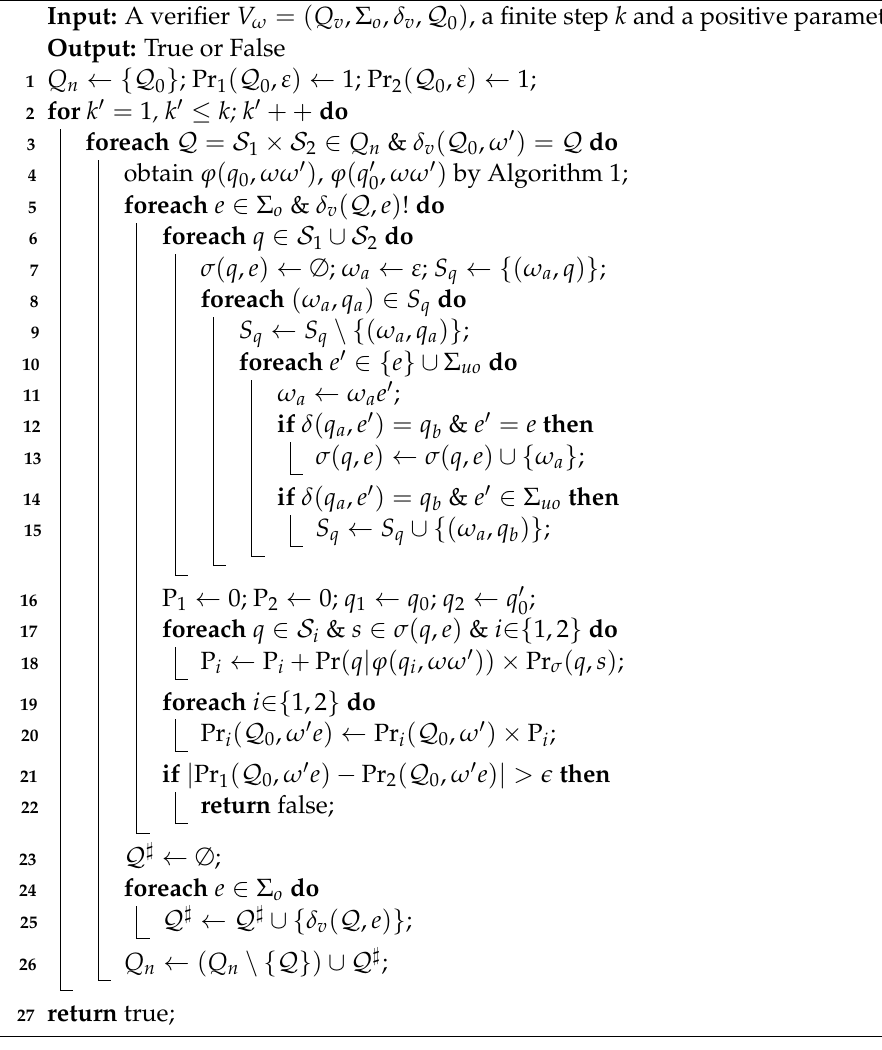
Algorithm 2: Step-based verification for state differential